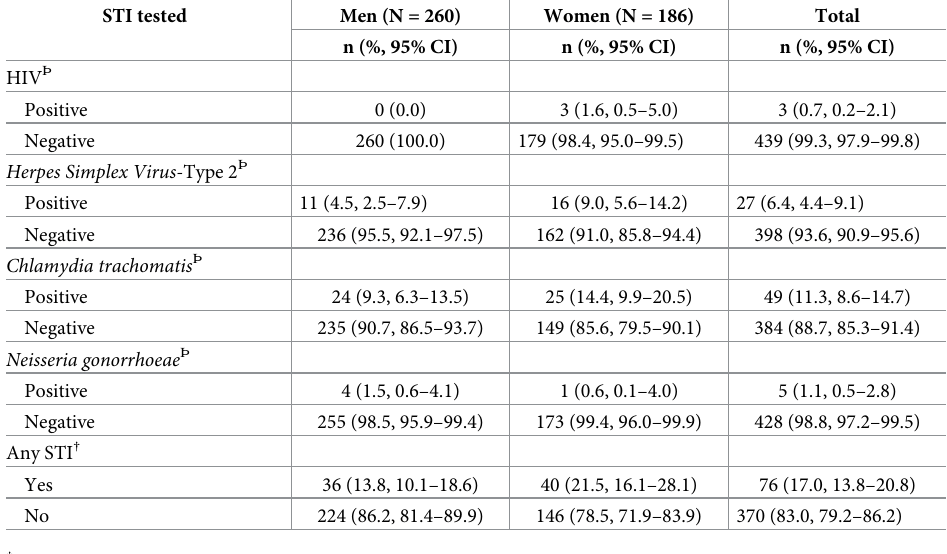
Table 2. Prevalence of laboratory confirmed STIs among participants who have had sex (N =